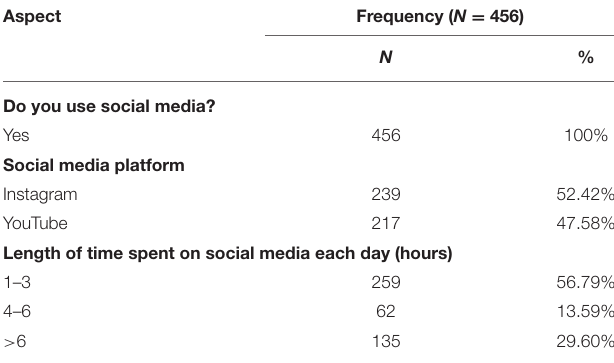
TABLE 2 | Social media usage survey.